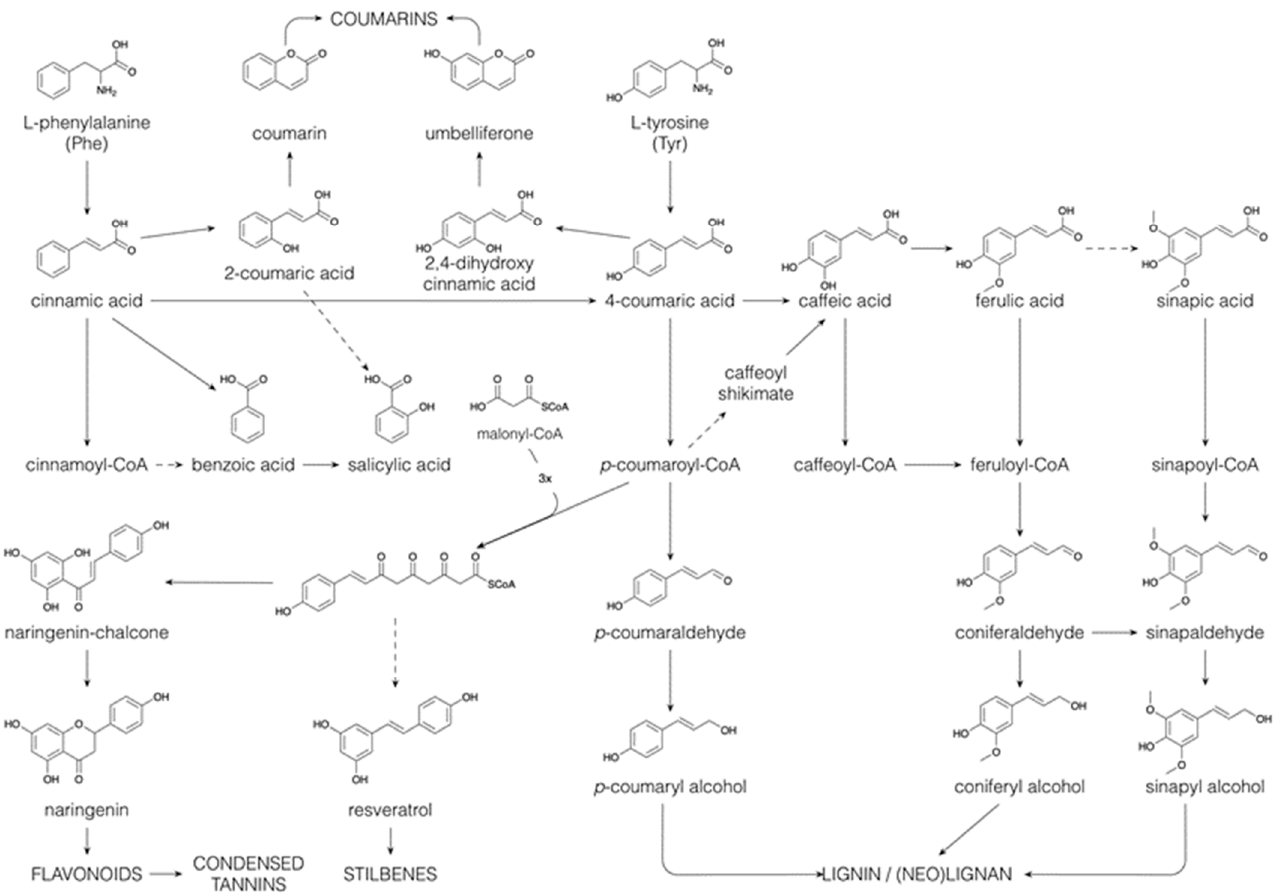
Figure 5. Biosynthesis of coumarins, benzenoids, flavonoids, stilbenoids, lignins and (neo)lignans via the phenylpropanoid pathway. Dashed arrows indicate multiple conversions.